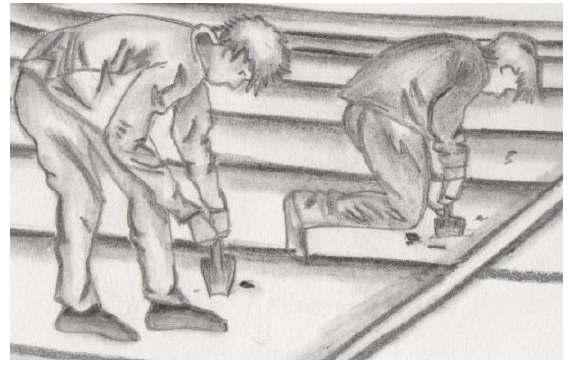
Figura 7- Bloco de partida de madeira com